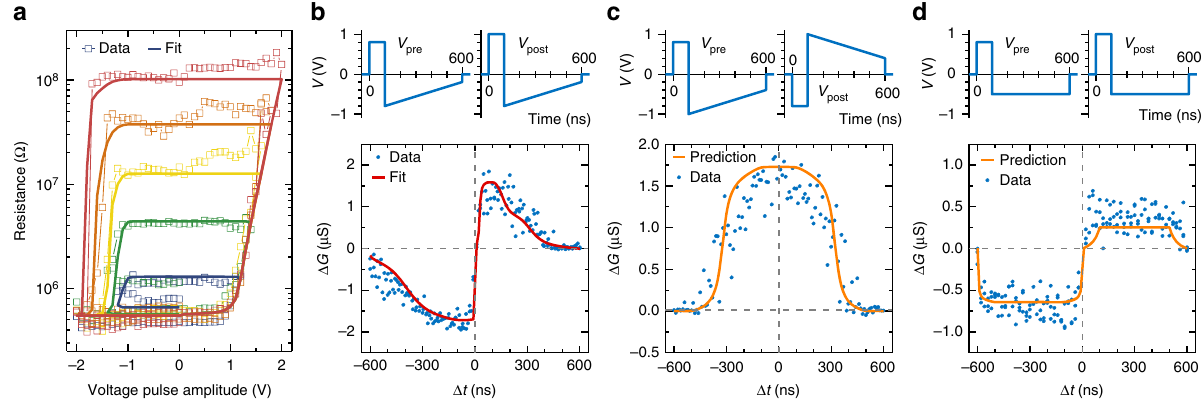
Figure 3 | Predicting STDP learning with ferroelectric synapses. ( a ) Multiple hysteresis loops of a ferroelectric memristor showing a clear dependence of resistance switching with the maximum pulse amplitudes. ( b – d ) Examples of STDP learning curves of different shapes. The pre- and post-synaptic spikes and conductance variations are shown in the top and bottom panels, respectively. For each device, simultaneous fits of data in a , b (solid lines) using equation (1) allow the prediction of new learning curves in c , d (orange